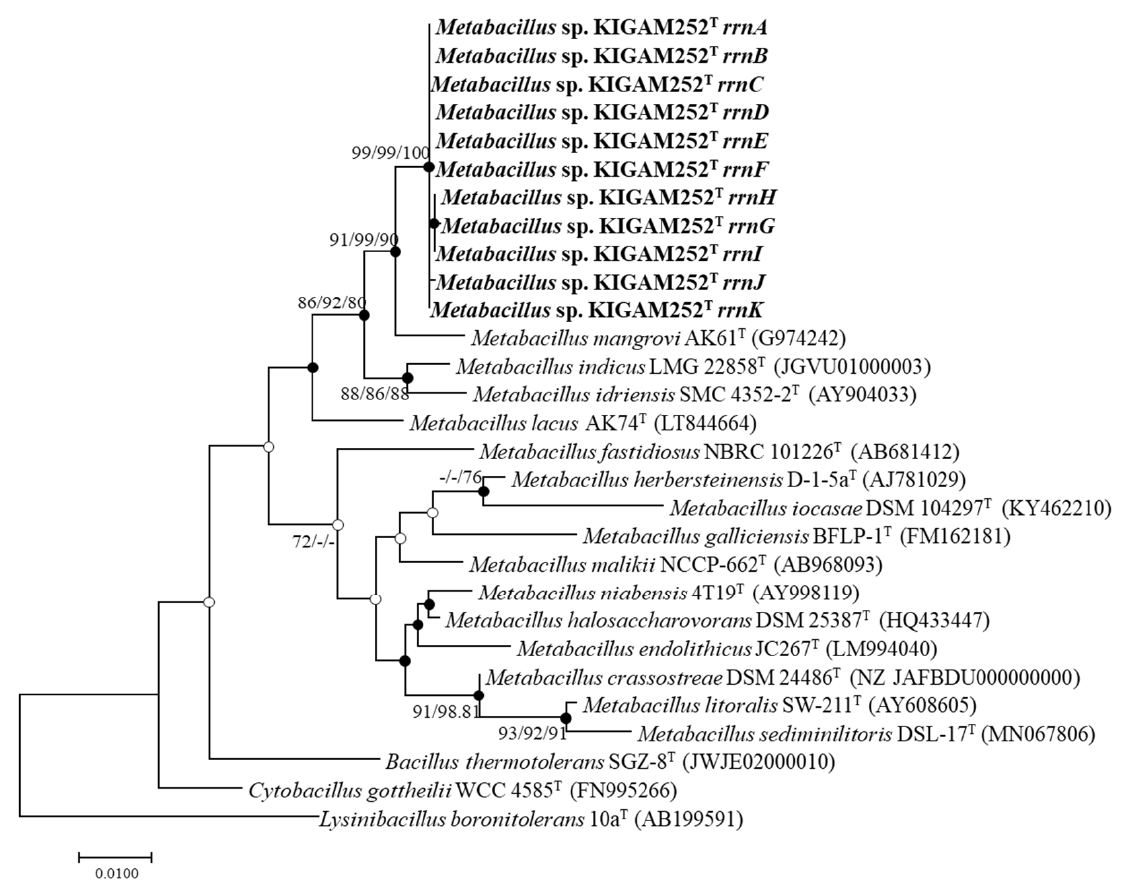
Figure 1. Maximum likelihood (ML) phylogenetic tree of strain KIGAM252 T and related type strains of Metabacillus species based on the 16S rRNA gene sequences. The closed circles represent nodes recovered by both the neighbor-joining (NJ) and maximum parsimony (MP) algorithms; the open circles represent nodes recovered by either NJ or MP. The numbers on the nodes indicate the bootstrap values (>70%) calculated using the ML/NJ/MP probabilities. Bar, 0.01 changes per nucleotide.